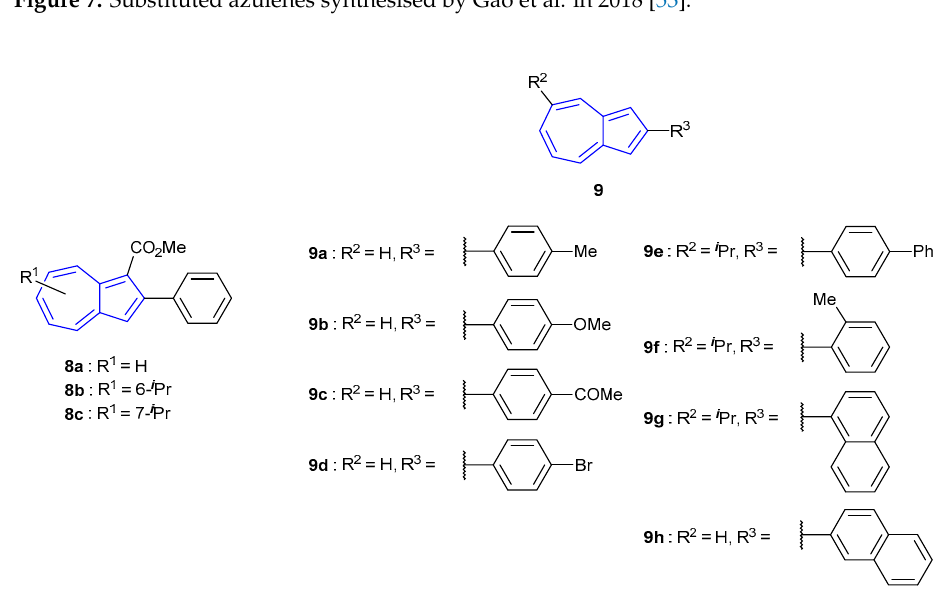
Figure 7. Substituted azulenes synthesised by Gao et al. in 2018 [53].